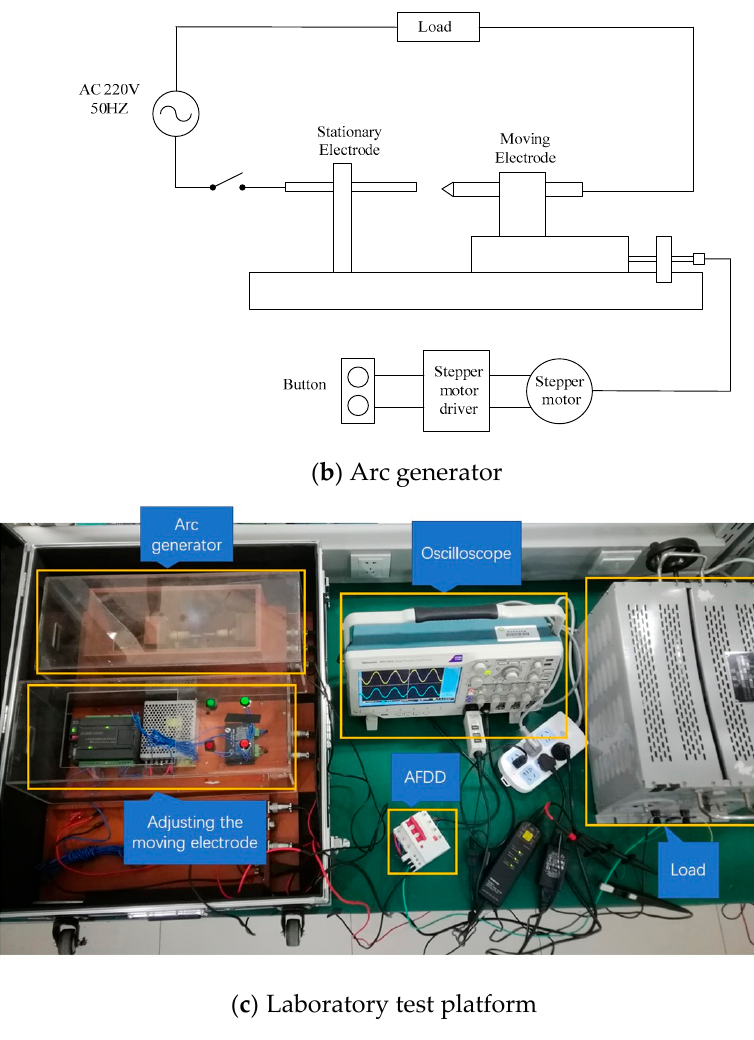
Figure 13. Series arc fault test.